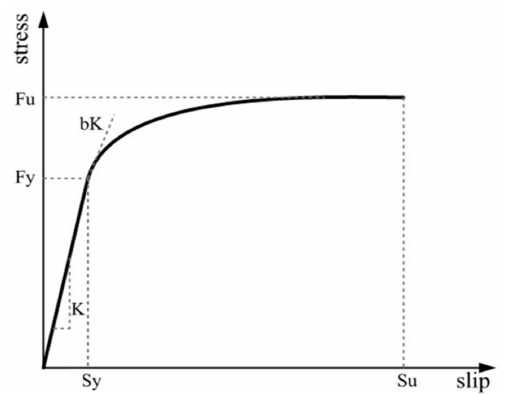
Figure 9. Bond_SP01 model reinforcement stress–slip envelope